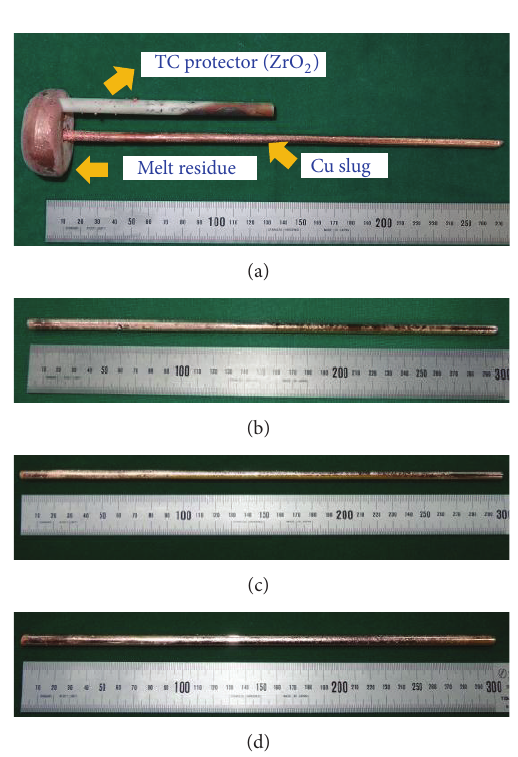
Figure 2: Photographs of surrogate copper slugs prepared in (a) test 𝑎 , (b) test 𝑏 , (c) test 𝑐 , and (d) test 𝑑